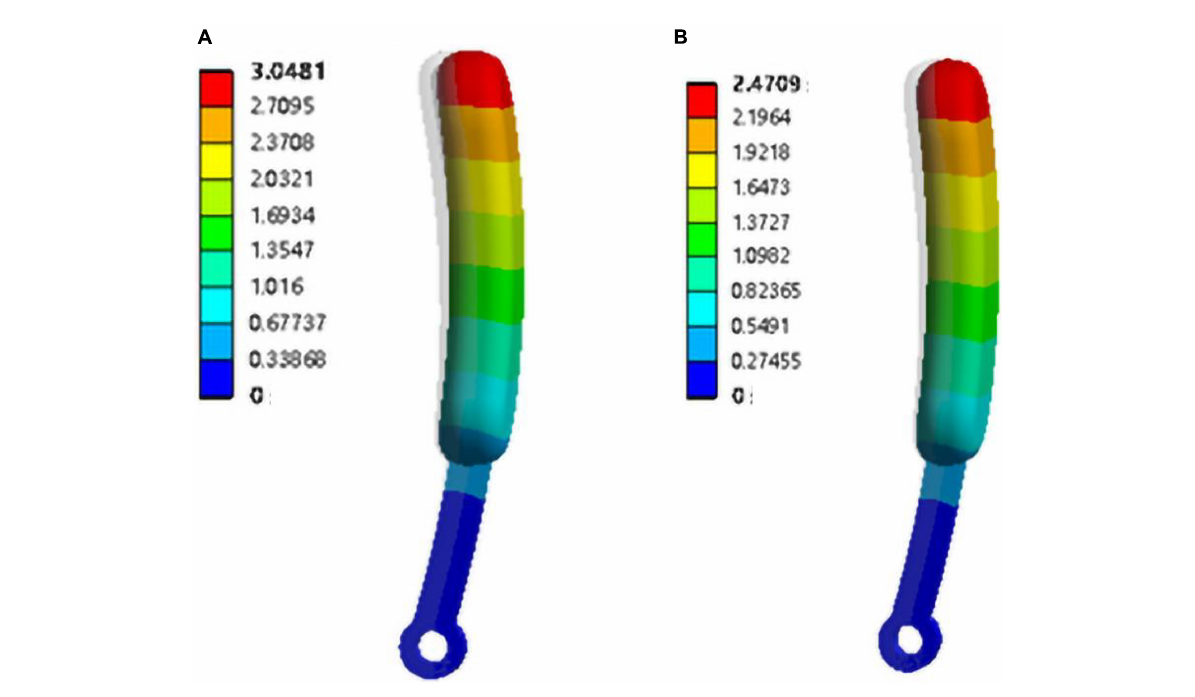
FIGURE11 Finger deformation simulation (A) silicone covered finger; (B) nylon